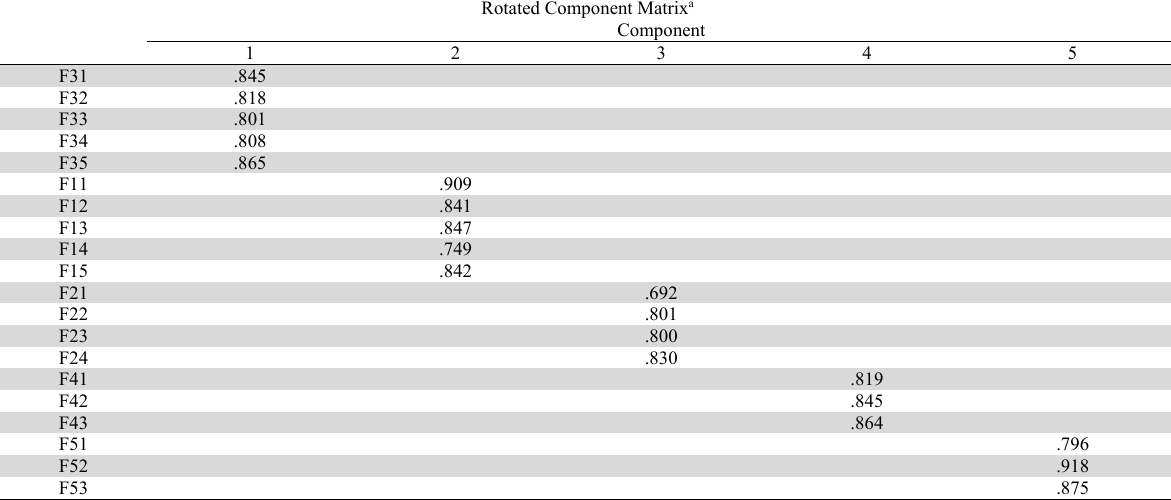
Exploratory Factor Analysis for independent variables